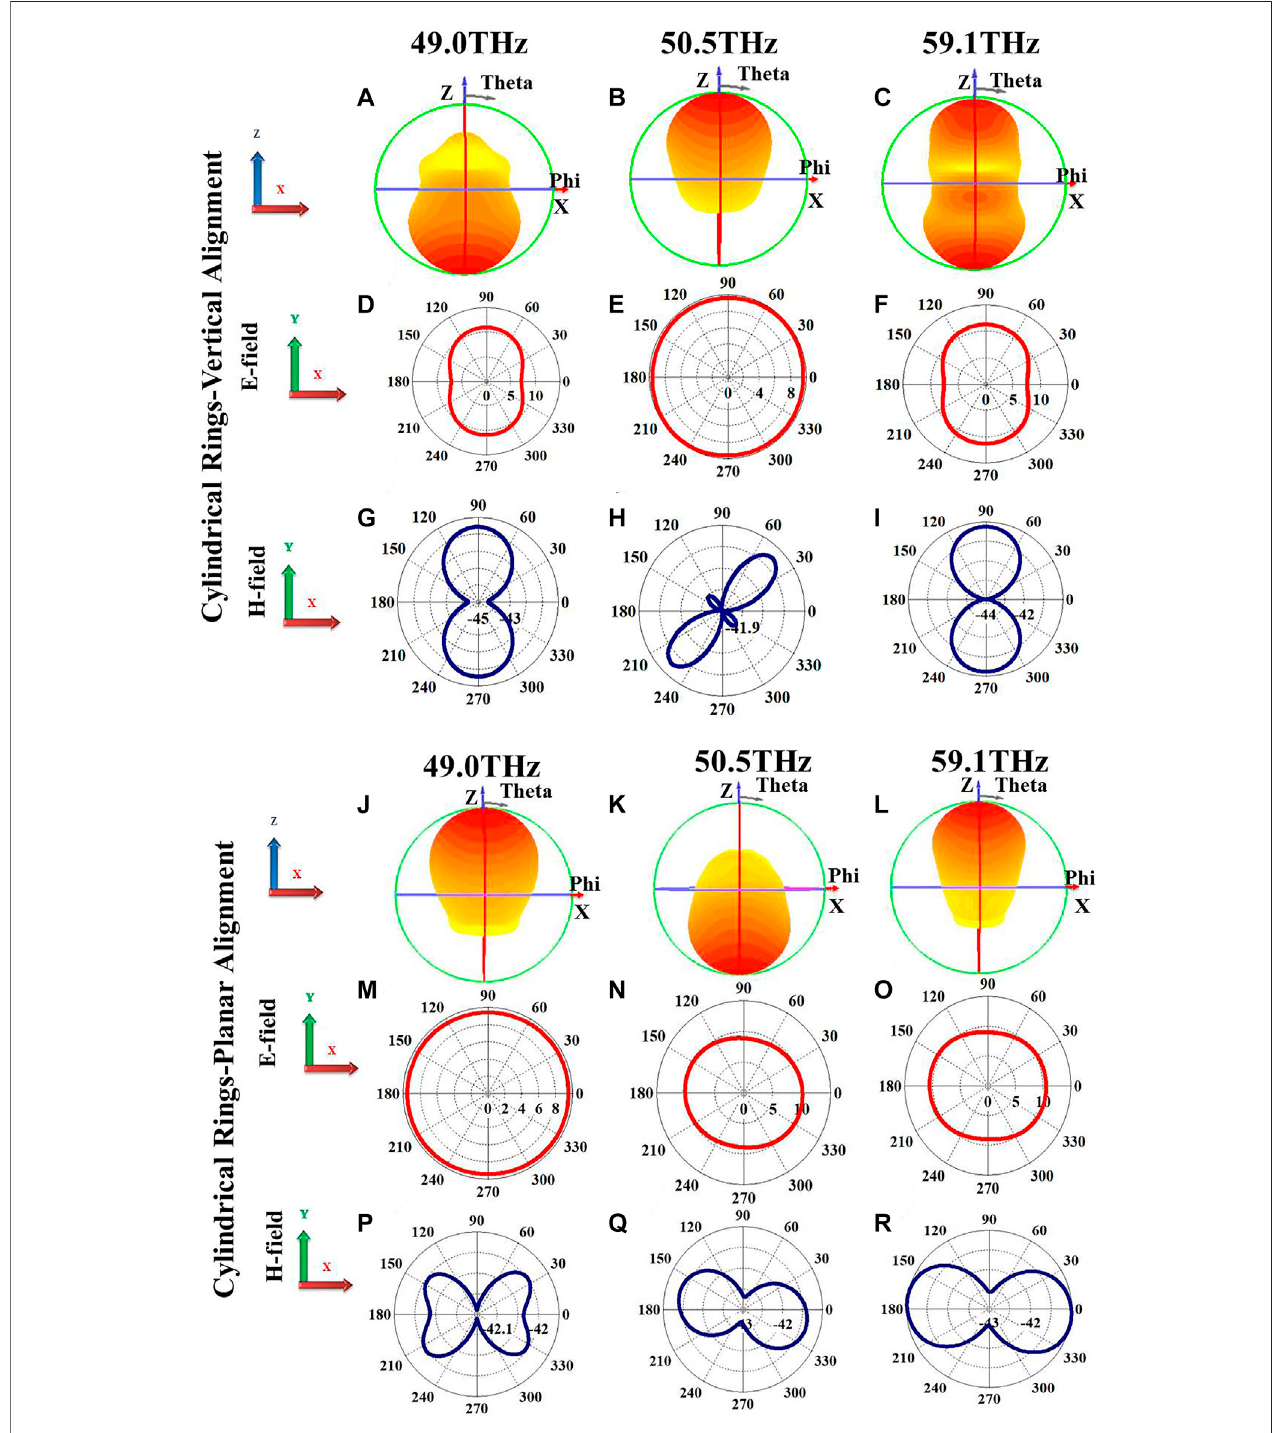
FIGURE 6 | Far- fi eld radiation and angular distribution of electric and magnetic fi elds for cylindrical rings: (A – C) . Far- fi eld radiation in XZ plane at f L , (D – F) . corresponding angular distribution of electric fi eld pro fi les (polarization) in XY plane and (G – I) . Corresponding angular distribution of magnetic fi eld pro fi les in XY plane; (J – L) . Far- fi eld radiation in XZ plane at f H , (M – O) . corresponding angular distribution of electric fi eld pro fi les (polarization) in XY plane and (P – R) . Corresponding angular distribution of magnetic fi eld pro fi les in XY plane, respectively.